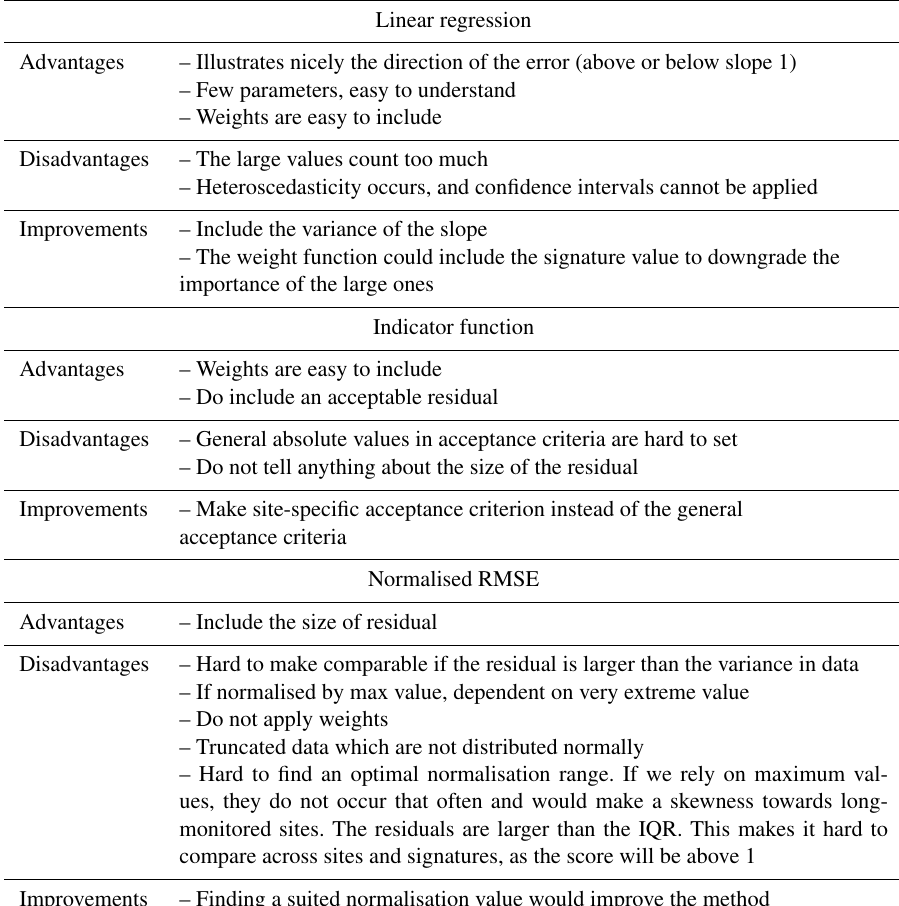
Table 5. The advantages, disadvantages, and improvements are outlined for the three methods.